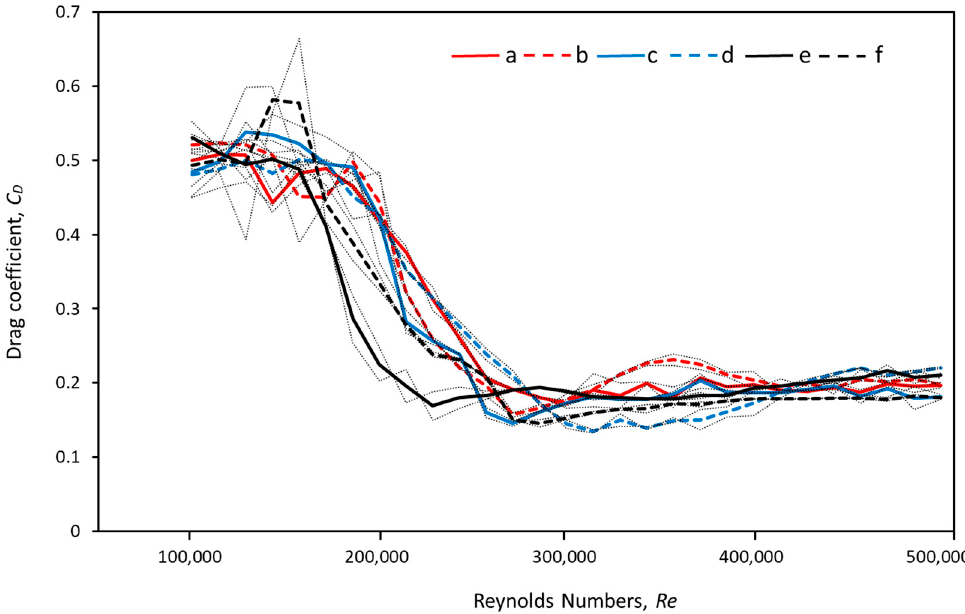
Figure 3. Drag coe ffi cient variation of the balls. In this figure, ( a , b ) represent the Face A and B Figure 3. Drag coefficient variation of the balls. In this figure, a and b represent the Face A and B orientation of the new Mikasa volleyball, respectively; ( c , d ) represent the Face A and B orientations orientation of the new Mikasa volleyball, respectively; c and d represent the Face A and B orientations of the old Mikasa volleyball, respectively; and ( e , f ) represent the Face A and B orientation of the old of the old Mikasa volleyball, respectively; and e and f represent the Face A and B orientation of the Molten volleyball, old Molten volleyball, respectively.